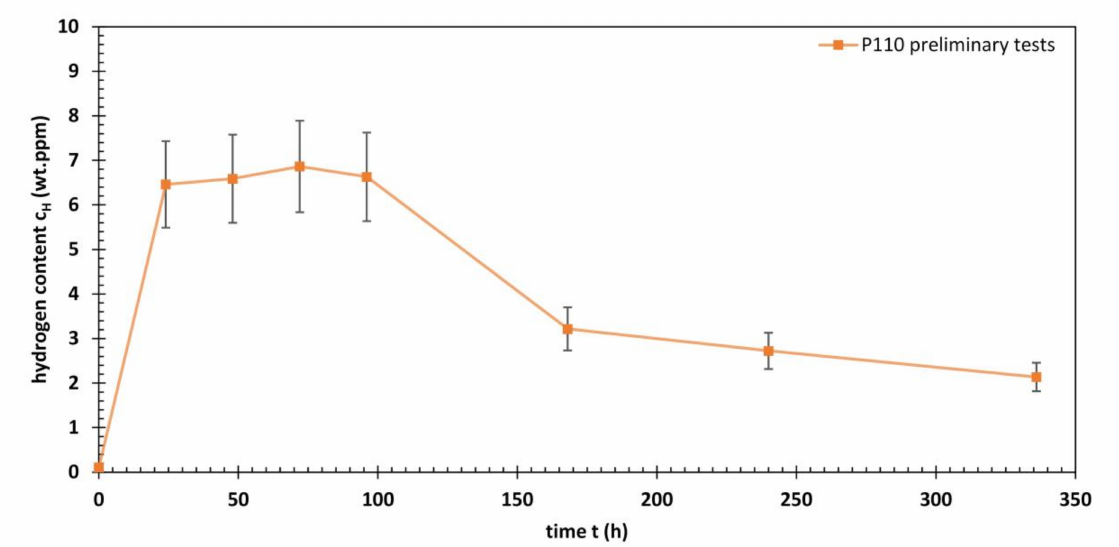
Figure 7. Hydrogen content of P110 after various times of ambient pressure testing in an acidified H 2 S-saturated aqueous brine solution with 5.0 wt.% NaCl and 0.5 wt.% CH 3 COOH at room temperature (NACE Solution